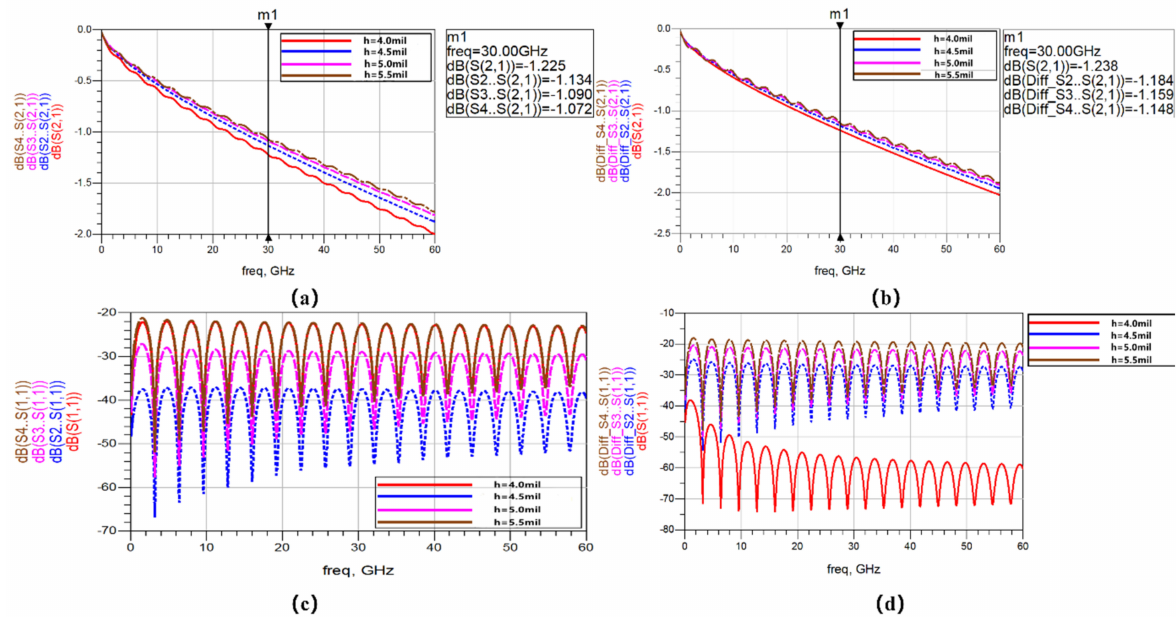
Figure 10. ( a ) Simulation results of insertion loss of single-ended strip coplanar waveguide; ( b ) simulation results of the insertion loss of the differential strip coplanar waveguide; ( c ) simulation results of return loss of single-ended strip coplanar waveguide; ( d ) simulation results of the return loss of the differential strip coplanar